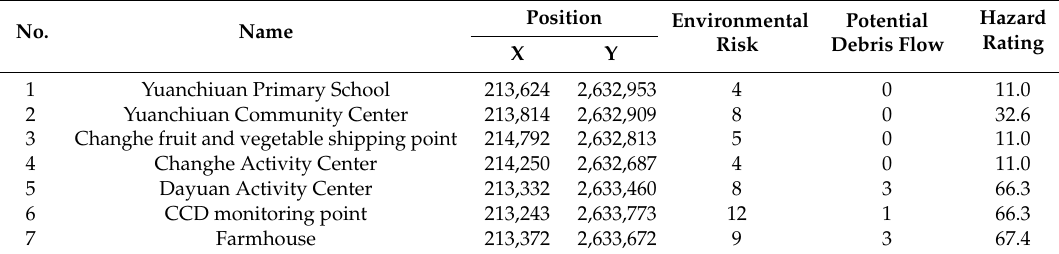
Figure 9. Environmental risk overlay in research area. Table 8. Hazard assessment of debris flow evacuation sites.